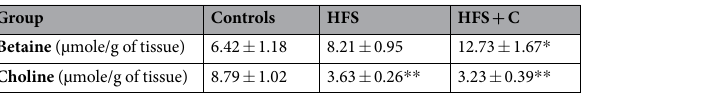
Multivariate statistical analysis of liver samples. OPLS-DA was performed for all three groups using both NMR and GC-MS datasets. The resulting scores plot (built with 2 predictive components, Fig. 2a) showed a clear discrimination between the three studied groups with a p-value of 3.35 10 − 20 (R2Y = 0.72, Q2Y = 0.64), using 63% of the total X-variance. The loading plots illustrate the contribution of the signal from several metab- olites to the discrimination model. The relative relevance in the OPLS-DA of the potential biomarkers is listed in Table 3. The first predictive component was related to the diet-induced metabolic variations involving a decrease of several aminoacids (aspartate, glutamate, isoleucine, leucine, lysine, valine), acetate, β -hydroxybutyrate, phosphoethanolamine, choline, lauric (C12:0), lauroleic (C12:1n-7), alpha-linoleic (18:2n-6), alpha-linolenic (C18:3n-3), gamma linolenic (C18:3n-6), arachidic (C20:0), gondoic (C20:1n-9), eicosopentaenoic (C20:5n-3), adrenic (C22:4n-6), erucic (C22:1n-9), docosapentaenoic (C22:5n-6), lignoceric (C24:0) acids associated with an increase of betaine (relevant for HFS + C group), glucose, glycogen, lysophosphatidylcholine, palmitoleic (C16:1n-7), steric (C18:0), oleic (C18:1n-9), cis-vaccenic (C18:1n-7), dihomo-gamma-linolenic (C20:3n-6) and arachidonic (C20:4n-6) acids in HFS/HFS + C groups (Fig. 2b and c). The second predictive component reflected